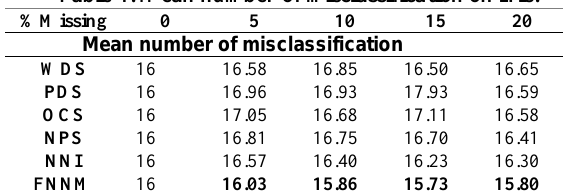
Table 4. Mean number of misclassification on Iris. %Missing